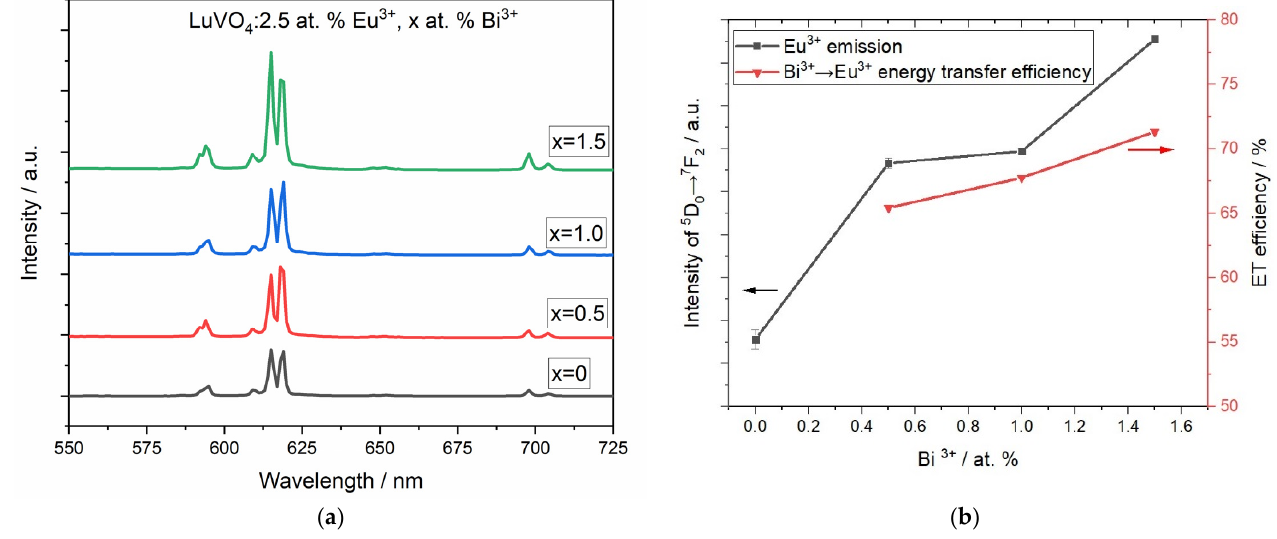
Figure 9. ( a ) Emission spectra of LuVO 4 : 2.5 at. % Eu 3+ , X Bi at. % (X = 0.5, 1.0 and 1.5) at λ exc = 350 nm. For the mono-doped sample, λ exc = 302 nm for comparison purposes. ( b ) Influence of the Bi 3+ content on the luminescence of Eu 3+ and energy transfer efficiency of Bi 3+ → Eu 3+ . On the other hand, it is possible to calculate the energy transfer efficiency (ET) between Bi 3+ → Eu 3+